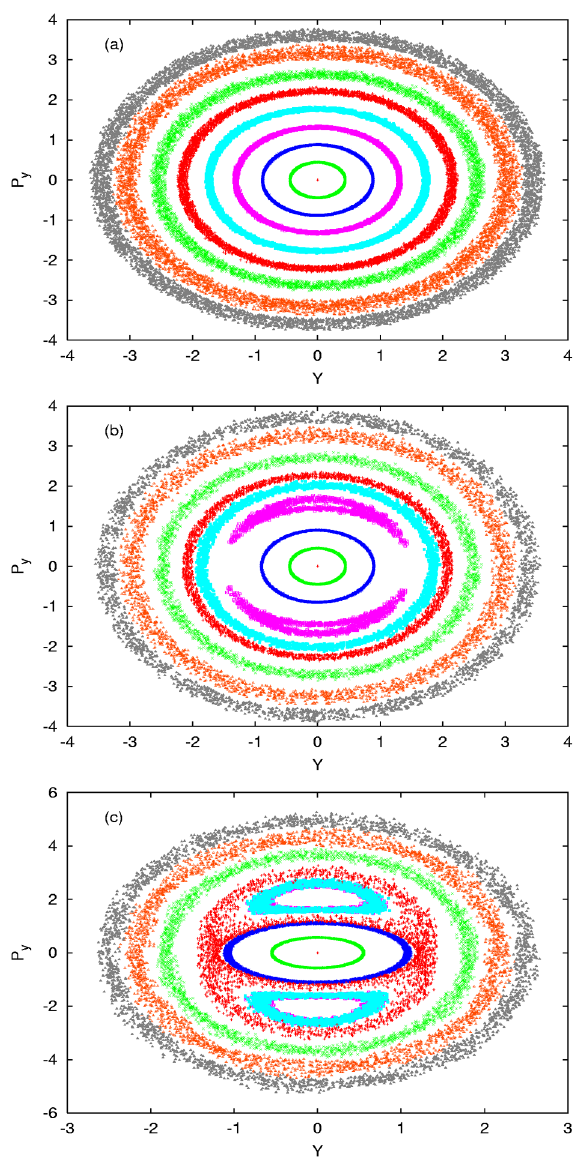
FIG. 12. (Color) (a) Stroboscopic map of the particle vertical phase space in the PSR lattice with zero envelope mismatch, M (cid:9) 0 , and for a beam intensity equal to one-quarter of the full beam intensity listed in Table I. (b) Map for M (cid:9) 0 : 02 . (c) Map for M (cid:9) 0 : 30 . The particle coordinates are normalized to the statistical Twiss parameters, such that the core boundary is (cid:9) 1 represented by Y 2 (cid:1) P 2 y